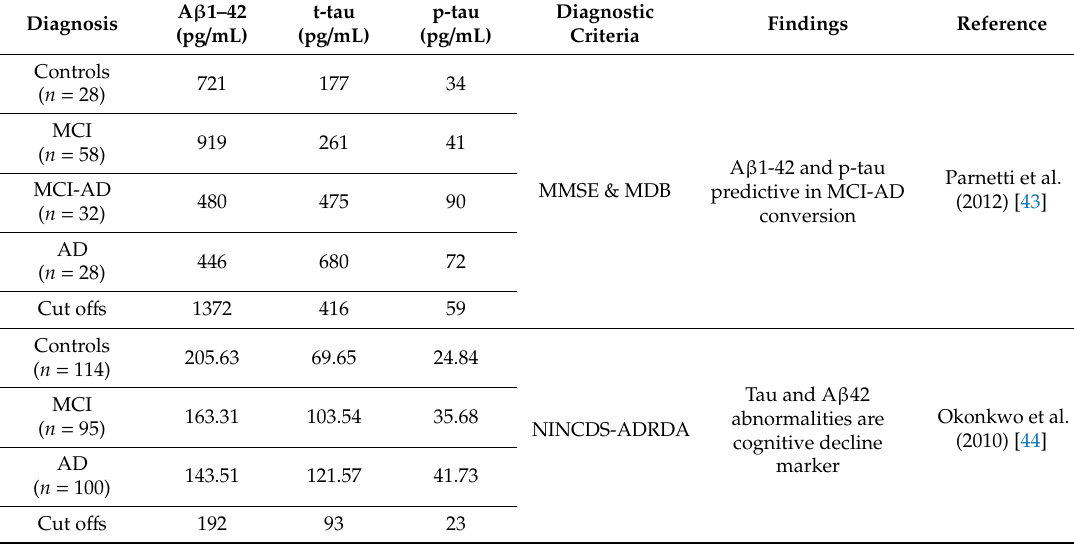
Table 2. Examples of studies that evaluated CSF β 1–42 (A β 1–42 ), total tau (t-tau), phosphorylated tau (p-tau) as potential biomarkers for MCI or